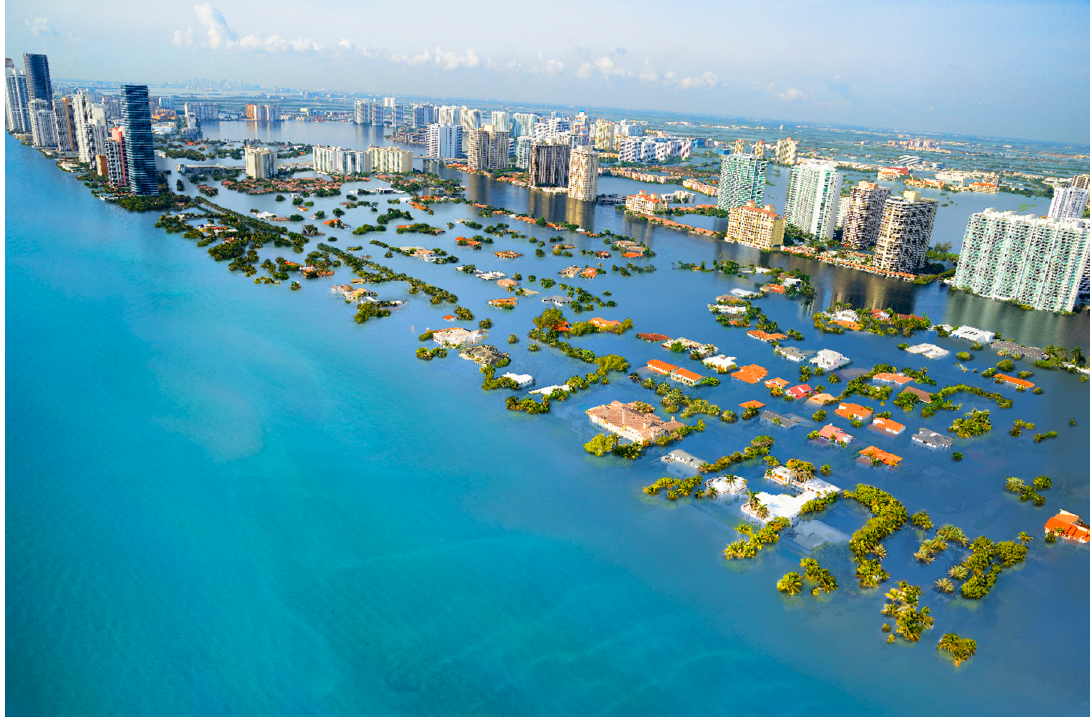
Figure 1. Climate Central’s depiction of Miami at 2 °C of warming .